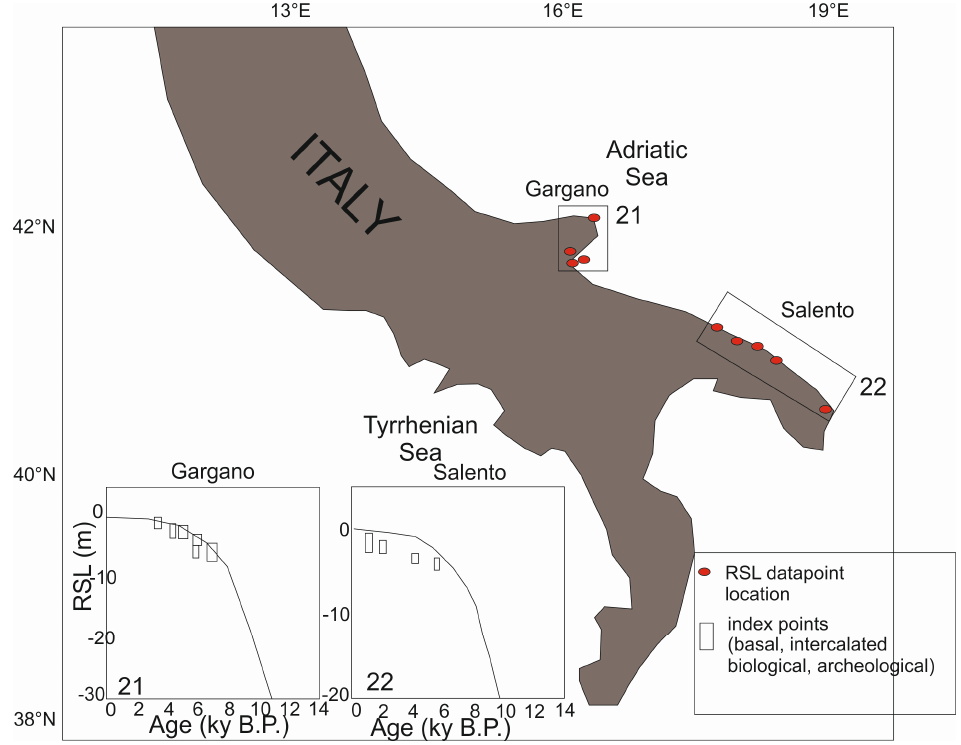
Figure 4. Relative sea level geological history during the Holocene in the Gargano region (21) and in the Salento region (22), modified after [85].